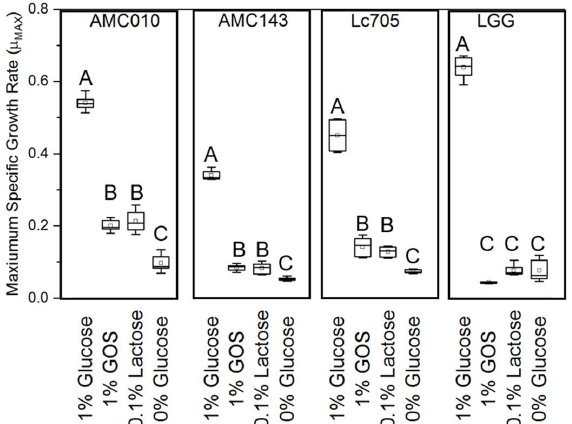
Figure 2. Specific growth rates of L. rhamnosus strains. Growth rates were calculated for each strain in MRS containing 1% glucose, 1% GOS, 0.1% lactose (the lactose component of GOS formulation), and in MRS without carbon and energy sources. Eight biological replicates, each in triplicate (three technical replications) were included in each experiment. Letters (A, B, C) represent statistical differences between treatments in each strain ( p < 0.05).